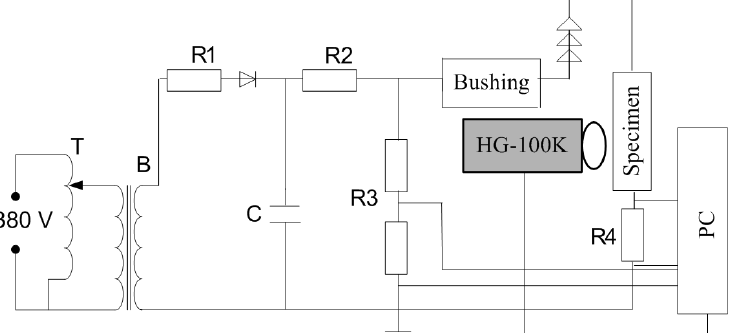
Figure 7. Test circuit. T-regulator, B-transformer, R1/R2-protective resistance, C-filtering capacitance, R3-resistance divider, R4-standard